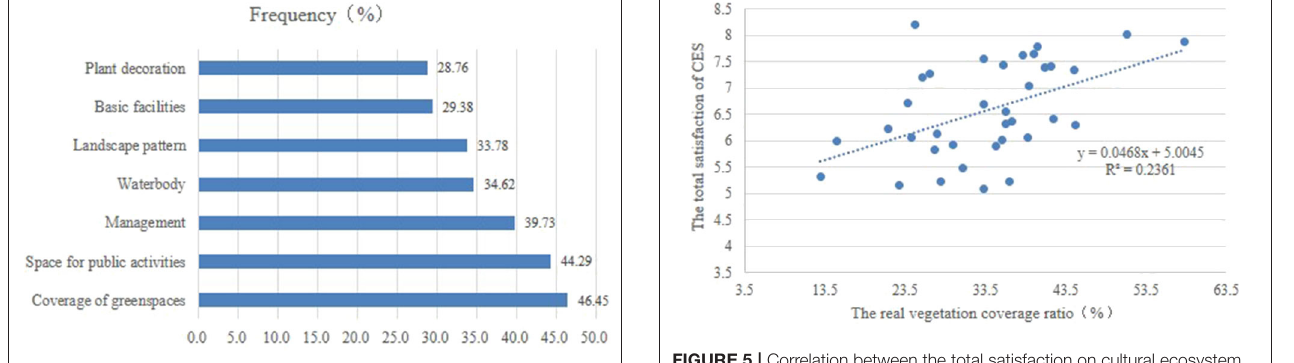
or clustered green spaces hinder walking activities. Therefore, future planning and design of residential green spaces should